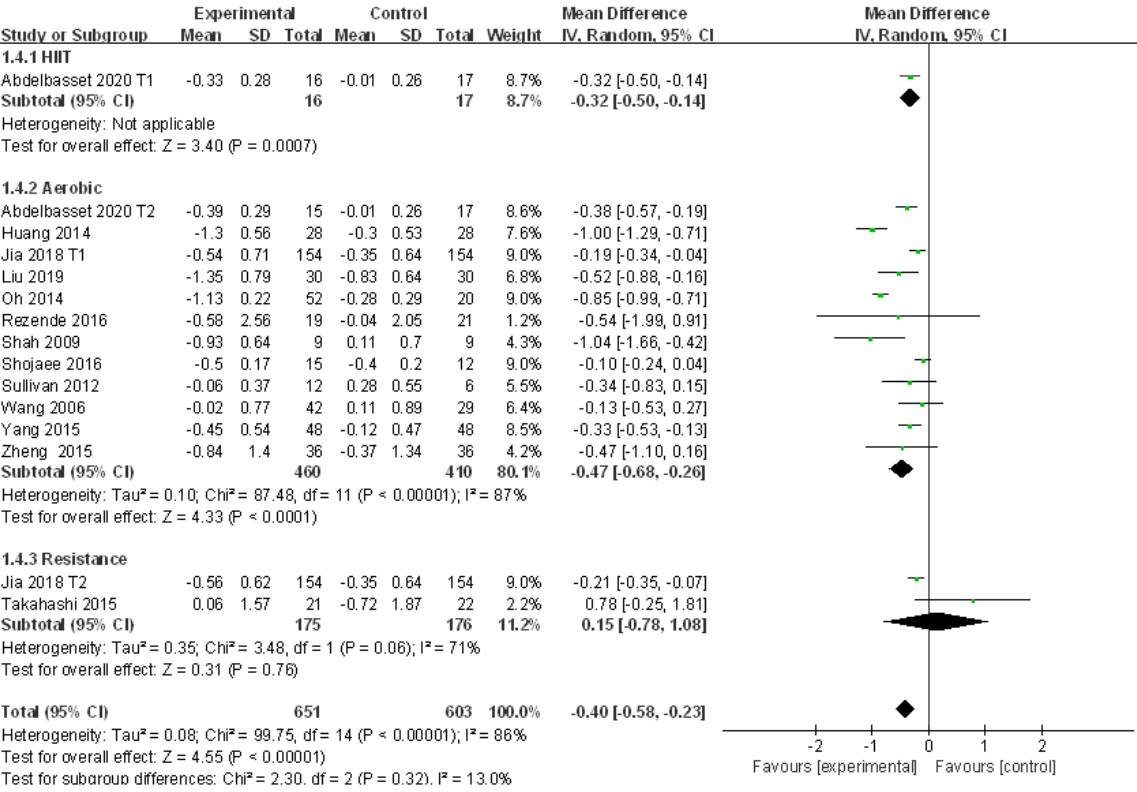
Figure 5. Subgroup analysis of different exercise styles on low density lipoprotein (LDL).